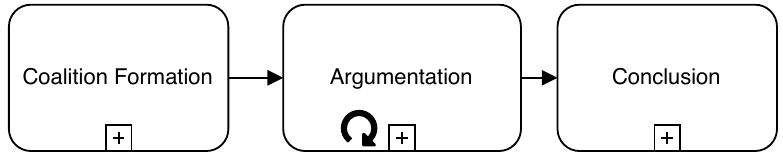
Figure 2. Phases of the Coordination